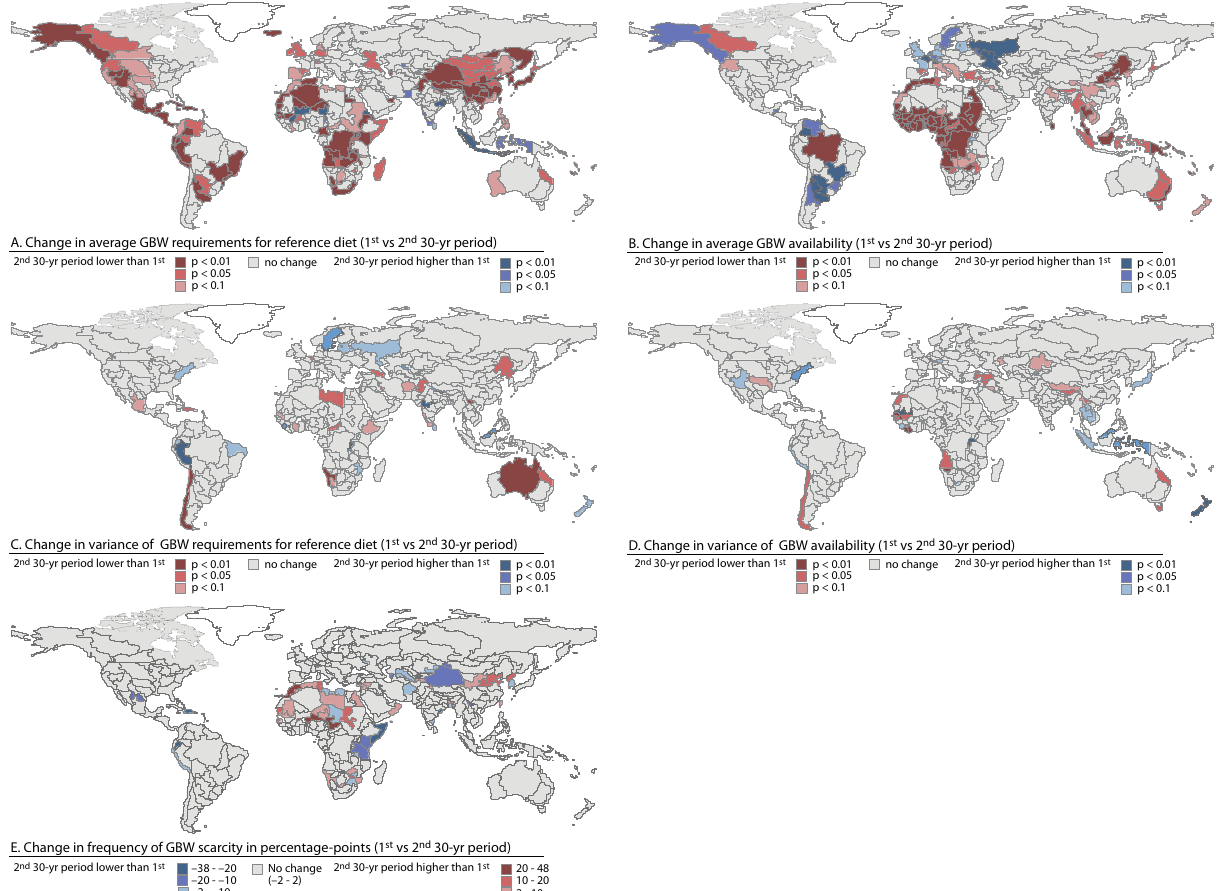
Fig. 4. Comparison of two 30yr climatic periods (i.e. model forced by hydrometeorological data of 1947–1976 vs. 1977–2006). (A) Change in average green-blue water (GBW) requirements for the reference diet; (B) change in average GBW availability; (C) change in variance of GBW requirements; (D) change in variance of GBW availability; and (E) change in frequency of GBW scarcity. The change assessment in average values was conducted with One-way ANOVA and the change assessment in variability was conducted with the Brown–Forsythe Levene’s test. Note that the calculations were made for constant reference population and agronomical practices (year 2000 situation) but varying climate within the indicated time